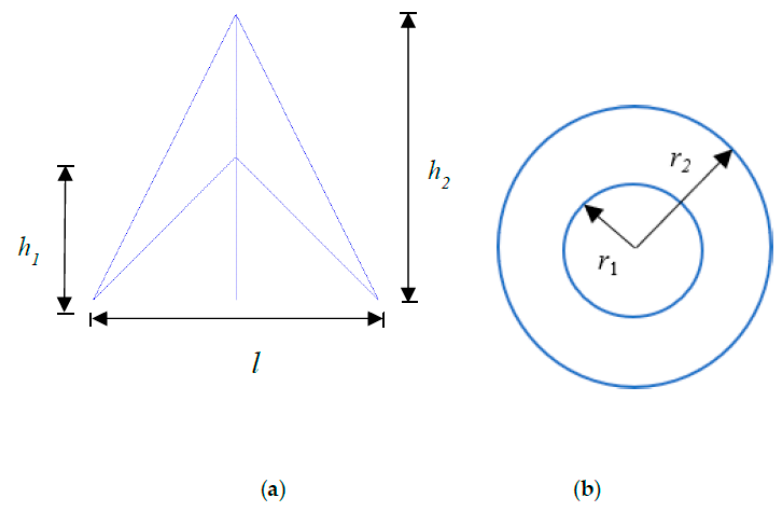
Figure 3. Cell geometry size: ( a ) topology shape size; ( b ) beam size.